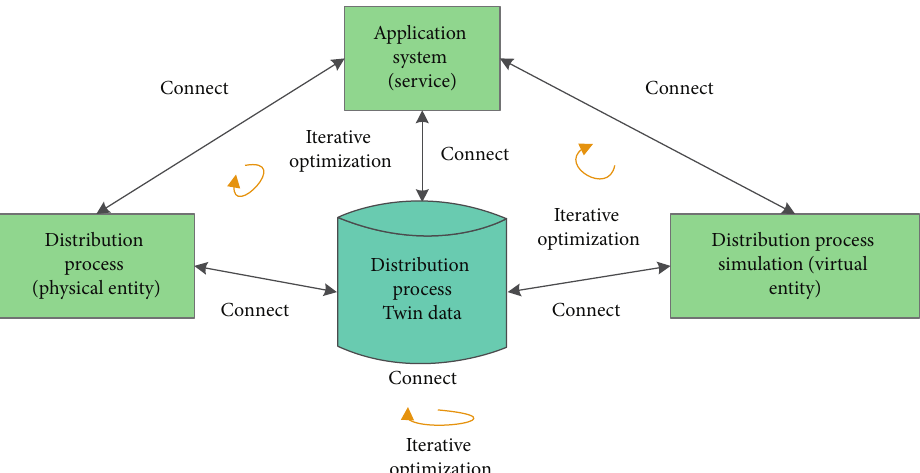
Figure 3: DTs five-dimensional model of logistics distribution.